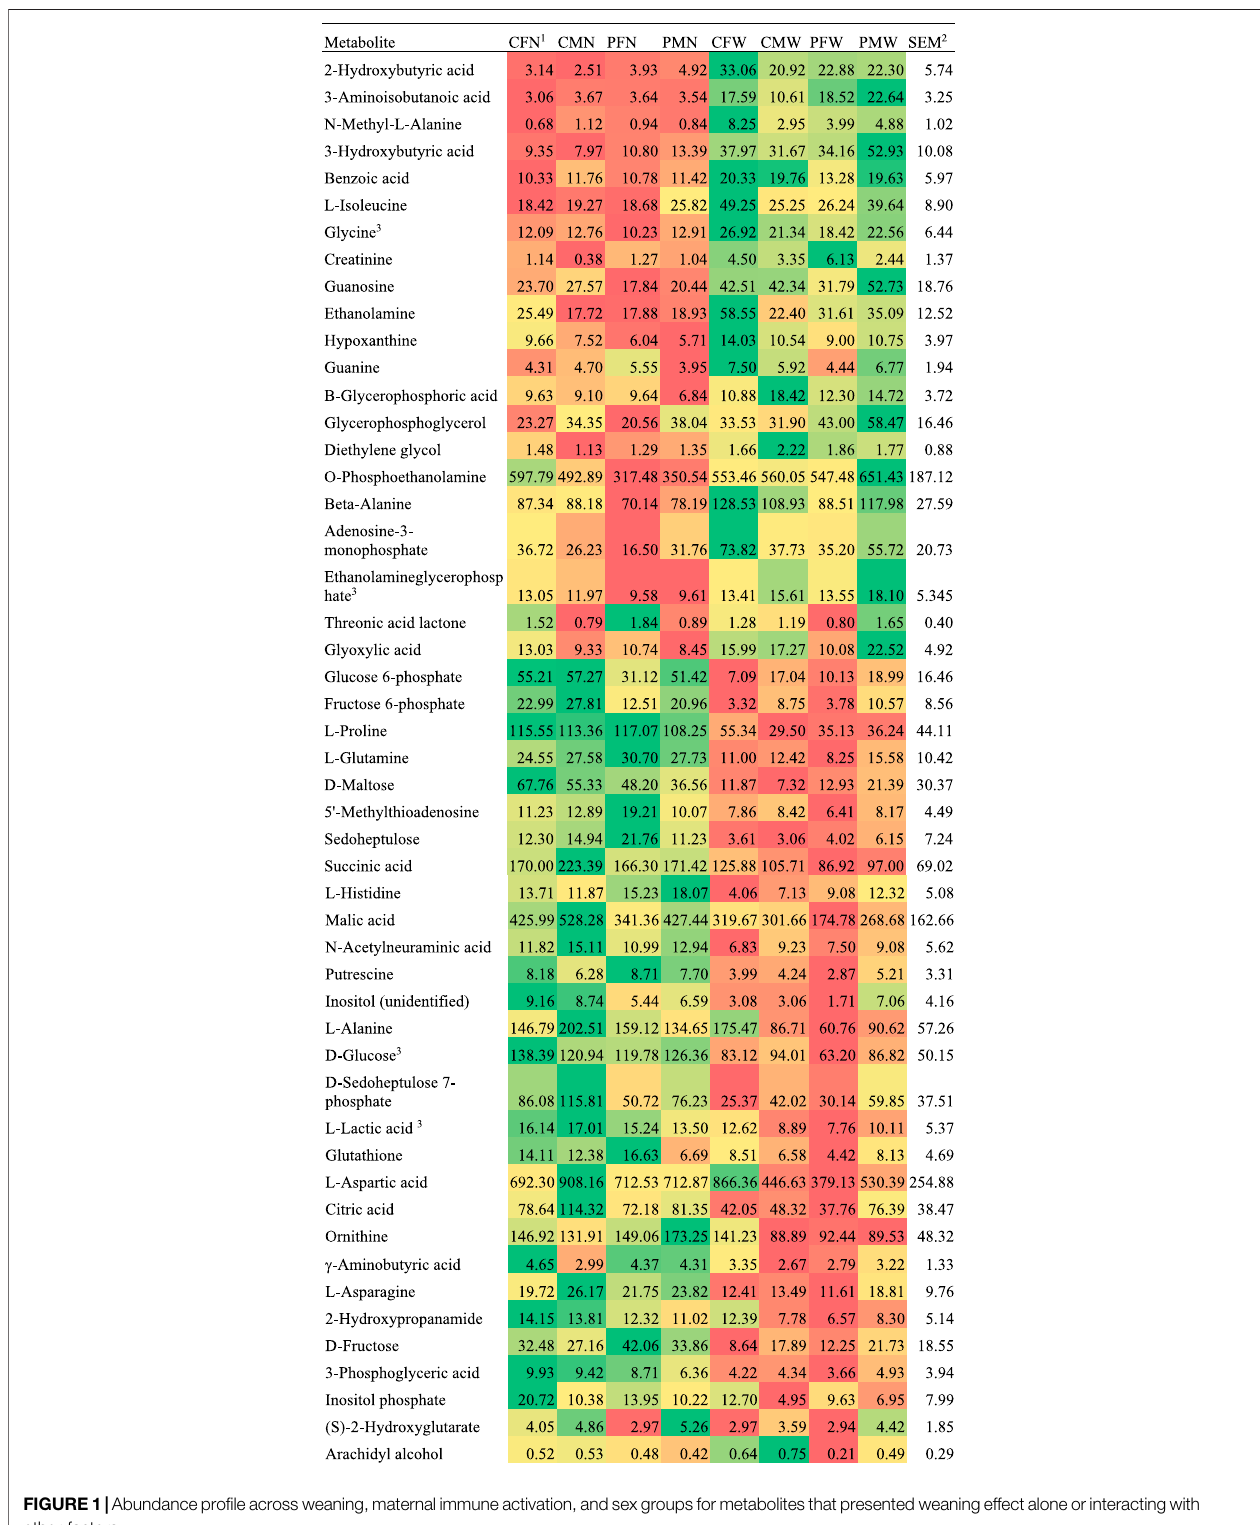
Frontiers in Molecular Biosciences |